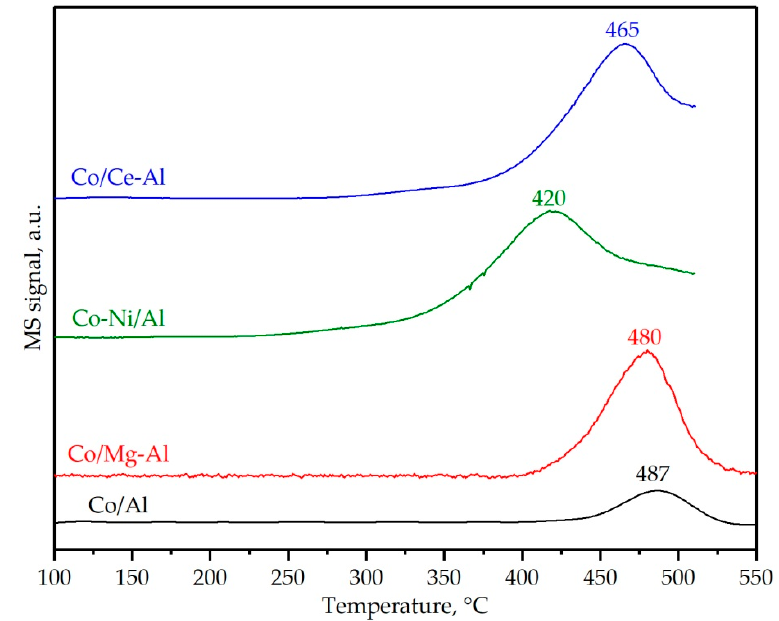
Figure 8. Close up view of the CH 4 ‐ TPRe profiles of the supported cobalt catalysts in the 100–550 °C temperature range.